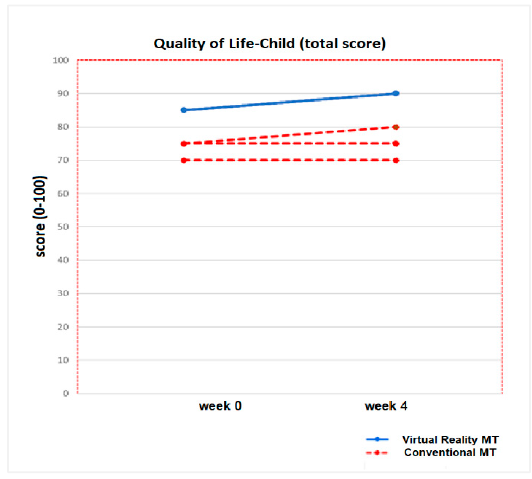
Figure 8. Progression of the Quality of life- Child (total score) of the ten children who completed both therapies (Virtual Reality MT: 5 children and Conventional MT: 5 children).